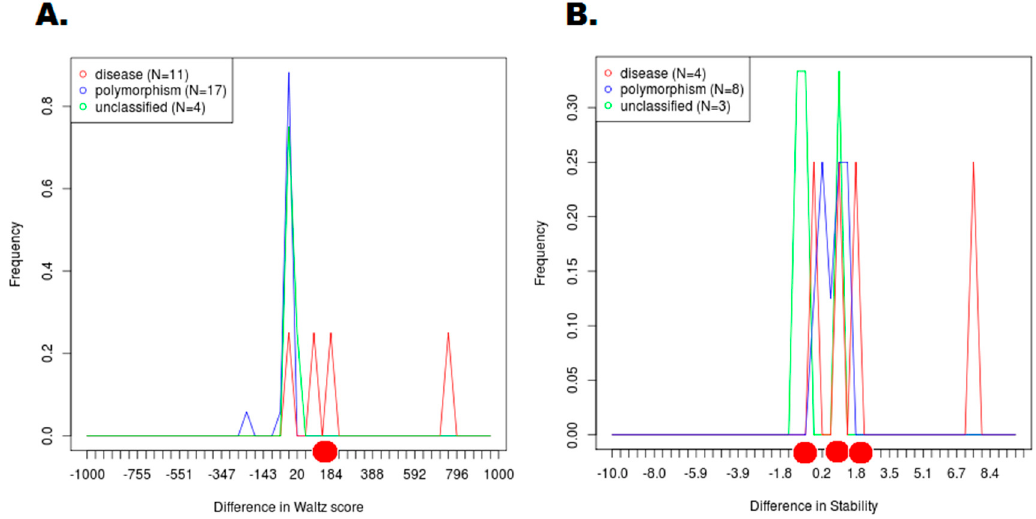
Figure 6. Representation of WALTZ and DDG scores for the mutations associated with HCC. ( A ) Difference in WALTZ scores with respect to its frequency of occurrence (red dot represents WALTZ score for LC3B Y113C); ( B ) Difference in stability scores with respect to its frequency of occurrence (red dot represents DDG scores for BECN1 I403T , SCD1 R126S and SCD1 Y218C).